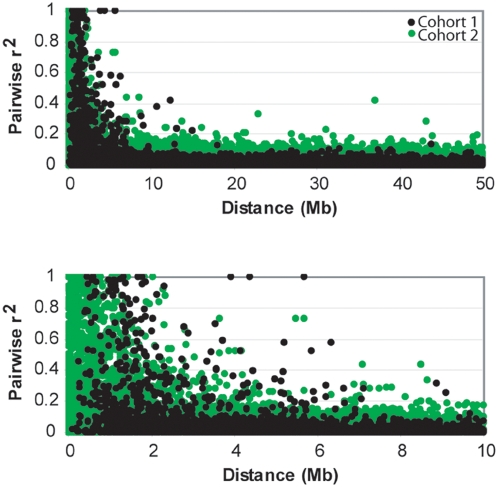
LD between ∼16,000 pairs of SNPs in CD-1 mice.The r2 measure of LD is shown as a function of physical distance for all common SNP pairs (top) and for common SNP pairs with an inter-SNP interval of ≤10 Mb (bottom) within Cohorts 1 and 2.